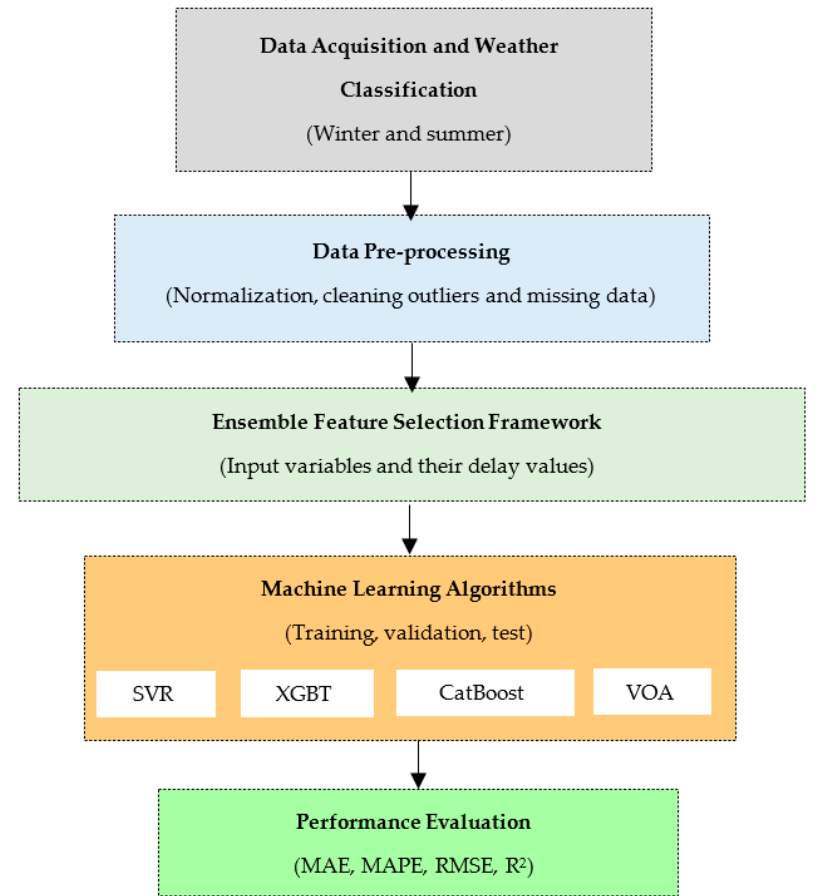
Figure 1. Flowchart of the proposed methodology.